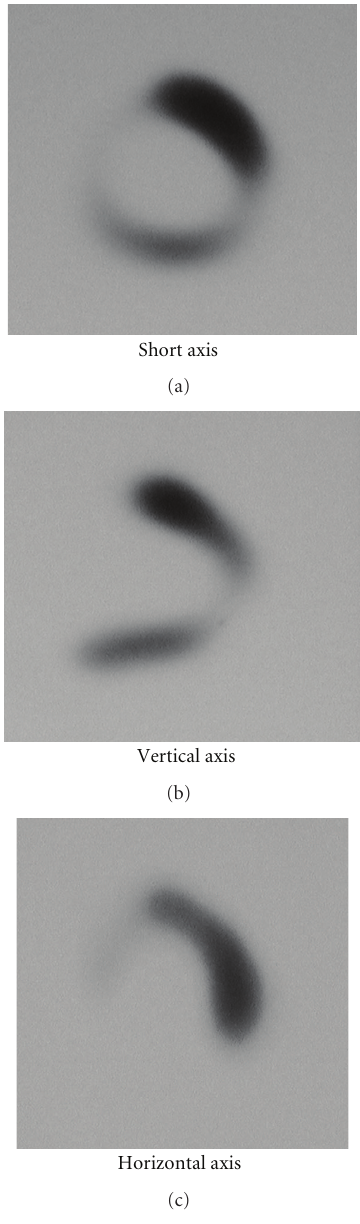
Figure 2: Myocardial scintigraphy with 99m Tc-tetrofosmin shows perfusion defect at the septal wall and hypoperfusion at the posterior wall and